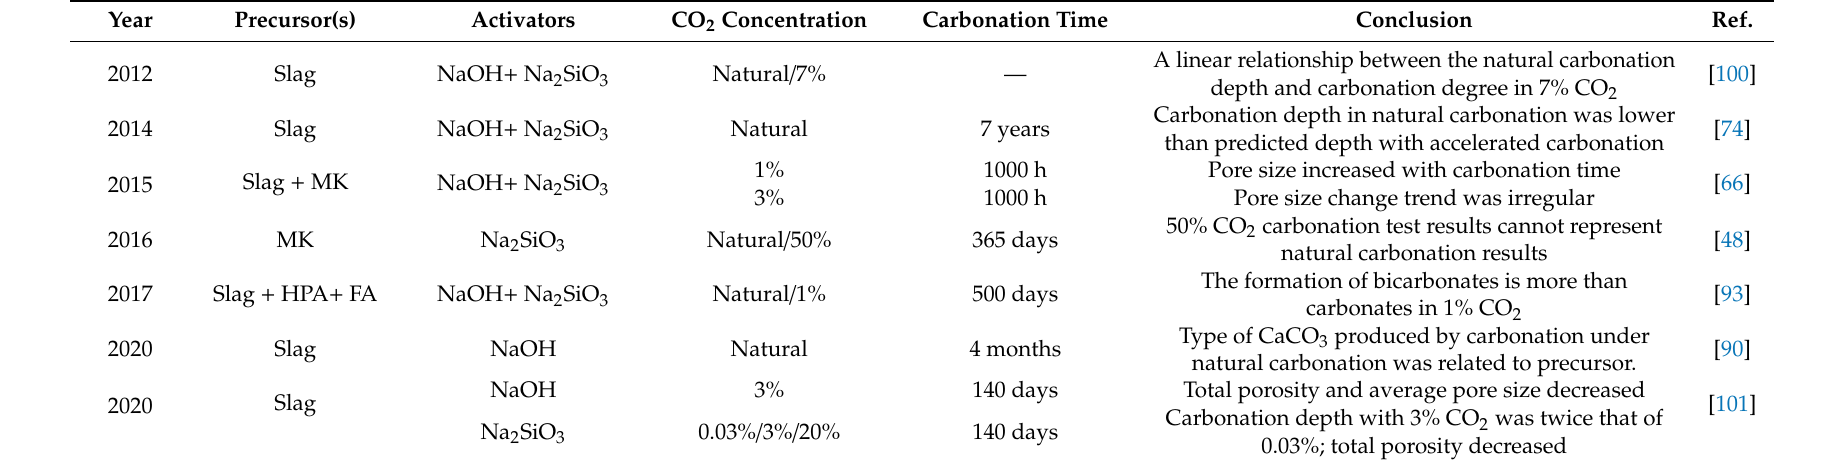
Table 2. Di ff erent conclusions from natural and accelerated carbonation of